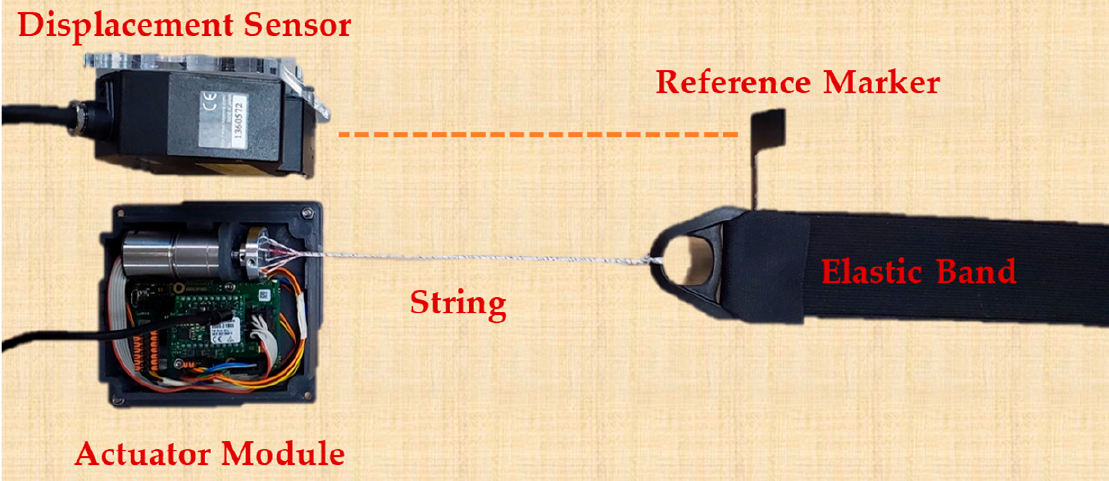
Figure 2. Test setup for actuator modeling (TSA actuation module with elastic band and laser displacement sensor) .